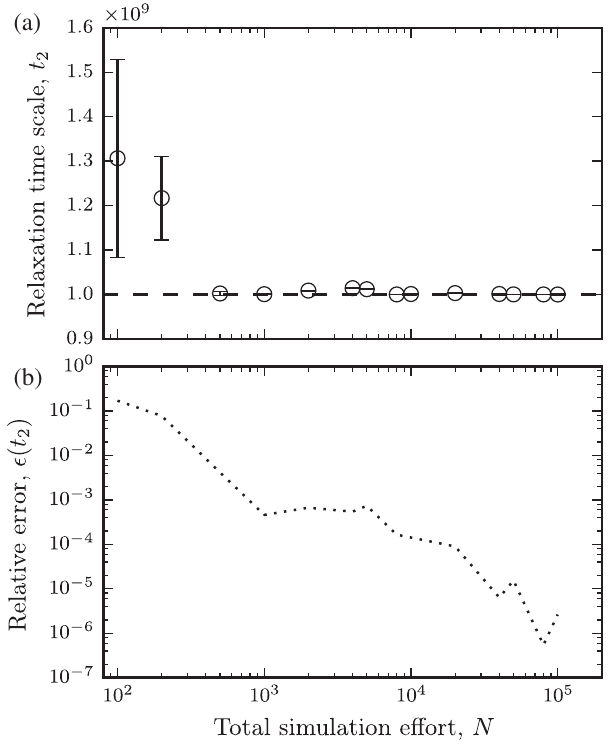
FIG. 2. Mean and standard error of the largest relaxation time scale t 2 total simulation effort N for metastable three-state system with barrier parameter b ¼ 9 . (a) Convergence of the mean value using short trajectories relaxing from the transition state. A correct estimate can be obtained 6 orders of magnitude before a single rare event would have occurred on average. (b) Standard error of the estimate. The estimation using long trajectories is unfeasible.